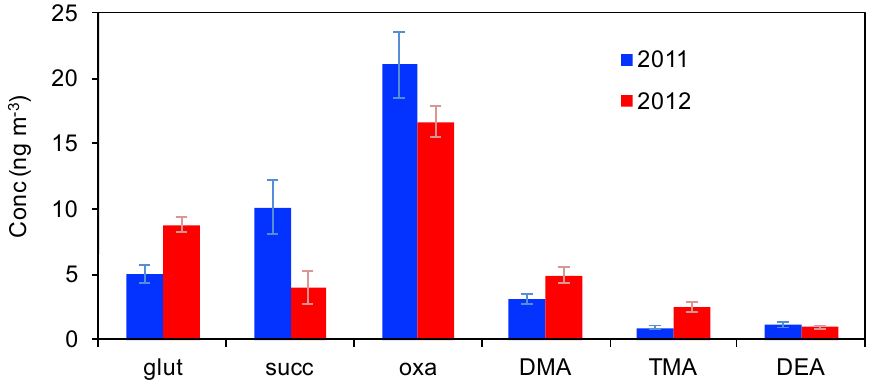
Figure 6. Concentrations of organic ions during AREX2011 and AREX2012: glutaric (glut), succinic acids (succ), oxalic acid (oxa), dimethylamine (DMA), trimethylamine (TMA), and diethylamine (DEA). Starting with carboxylic acid, the average concentration of oxalic acid during AREX cruise was 17 ± 6 ng m − 3 (2011: 19 ± 11 ng m − 3 ; 2012: 14 ± 4 ng m − 3 ), while succinic and glutaric were